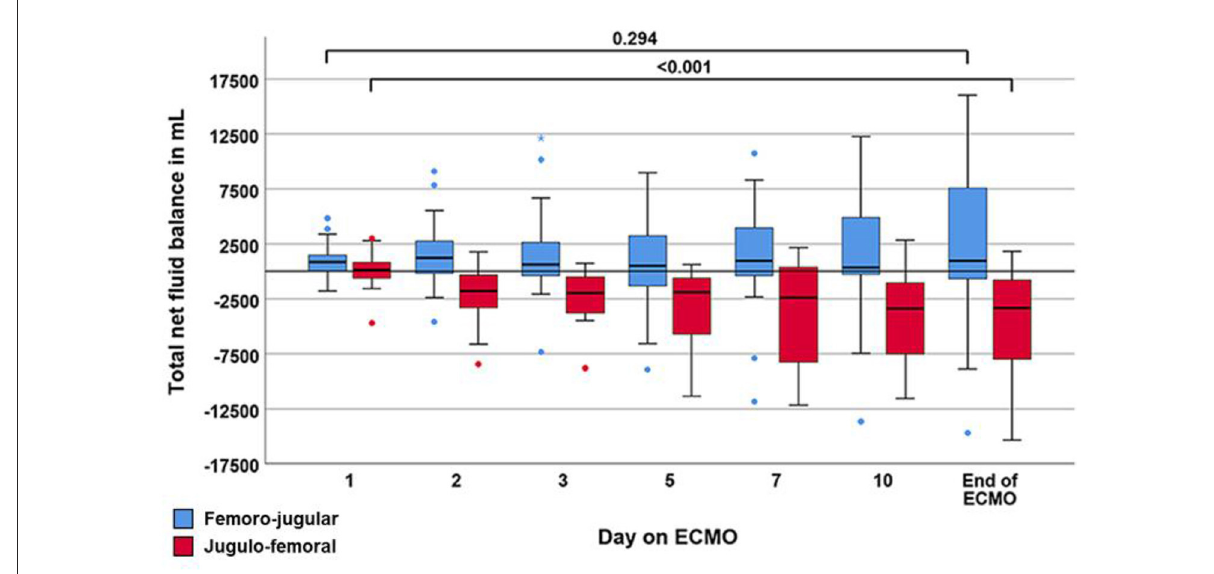
FIGURE3 Boxplot showing the trajectory of net fluid balance during the course of extracorporeal membrane oxygenation (ECMO). Data are expressed as median, minimum, maximum, 25th percentile, and 75th percentile. Circles and stars represent outliers with more than one and a half times or more than three times the length of the box from either end of the